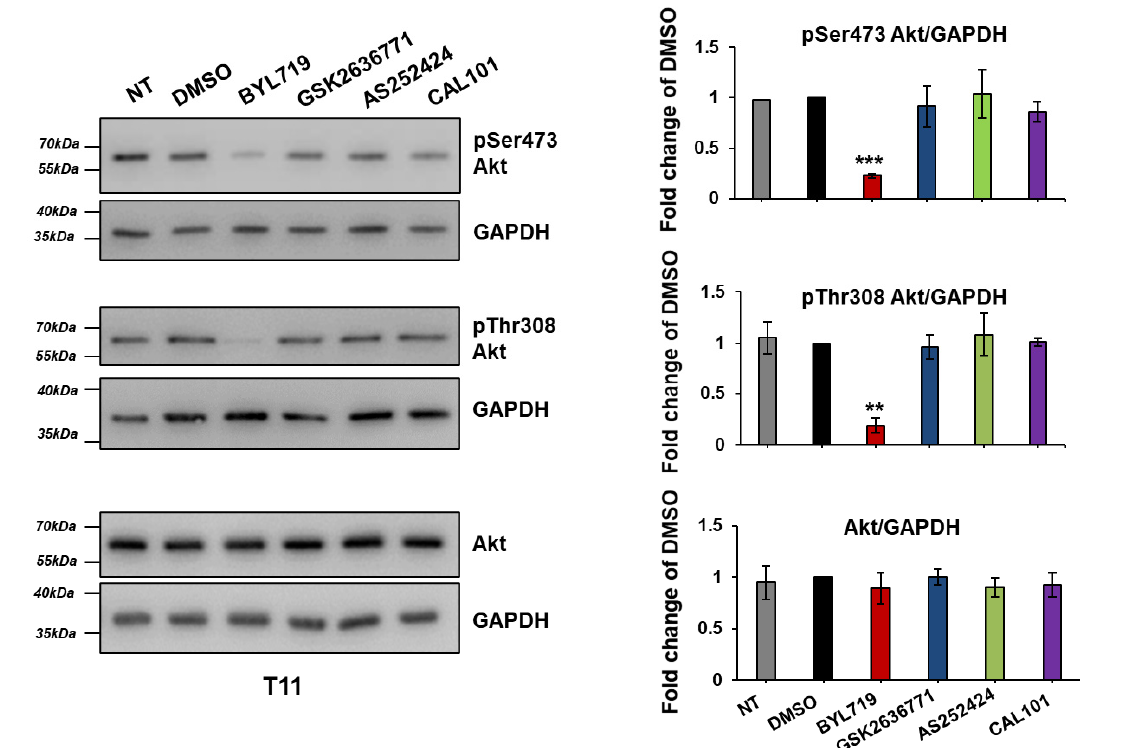
Figure 13. T11 cells were left untreated (NT) or treated with 1 µM of the isoform-specific inhibitors or DMSO in complete medium supplemented with 10% FBS. After 1 h, cells were Lysed and lysates were analyzed Western blotting. GAPDH was used as loading control. Signals were visualized using Chemidoc™ MP Imaging System. Graphs indicate results from densitometry analysis of phosphorylated or total Akt normalized to loading control and expressed as fold change of results from DMSO-treated cells. Data are means ± SEM from the following numbers of independent experiments: pSer473 Akt, n = 3 (apart from NT, n = 1 and BYL719, n = 2); pThr308 Akt and total Akt, n = 3 (apart from NT, n = 2). ** p < 0.01, *** p < 0.001 vs. DMSO.